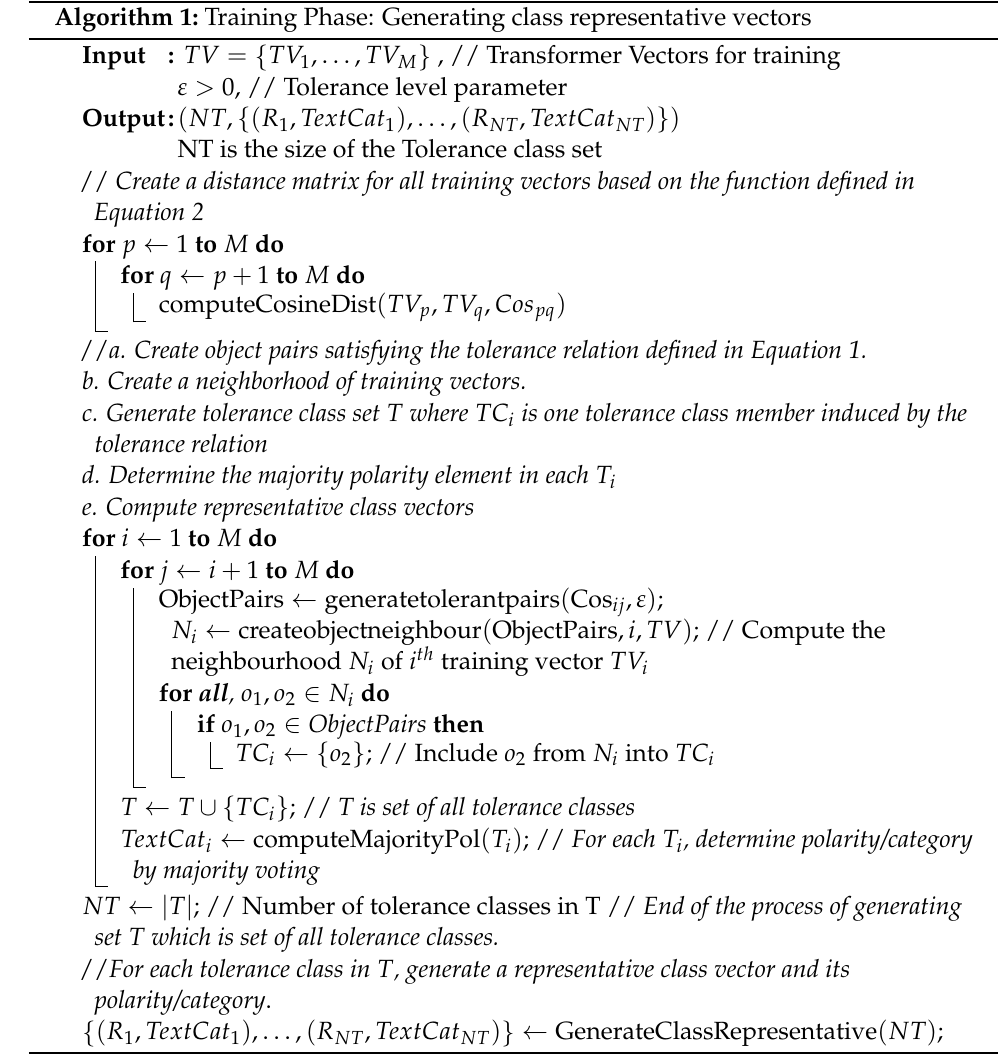
Algorithm 1: Training Phase: Generating class representative vectors